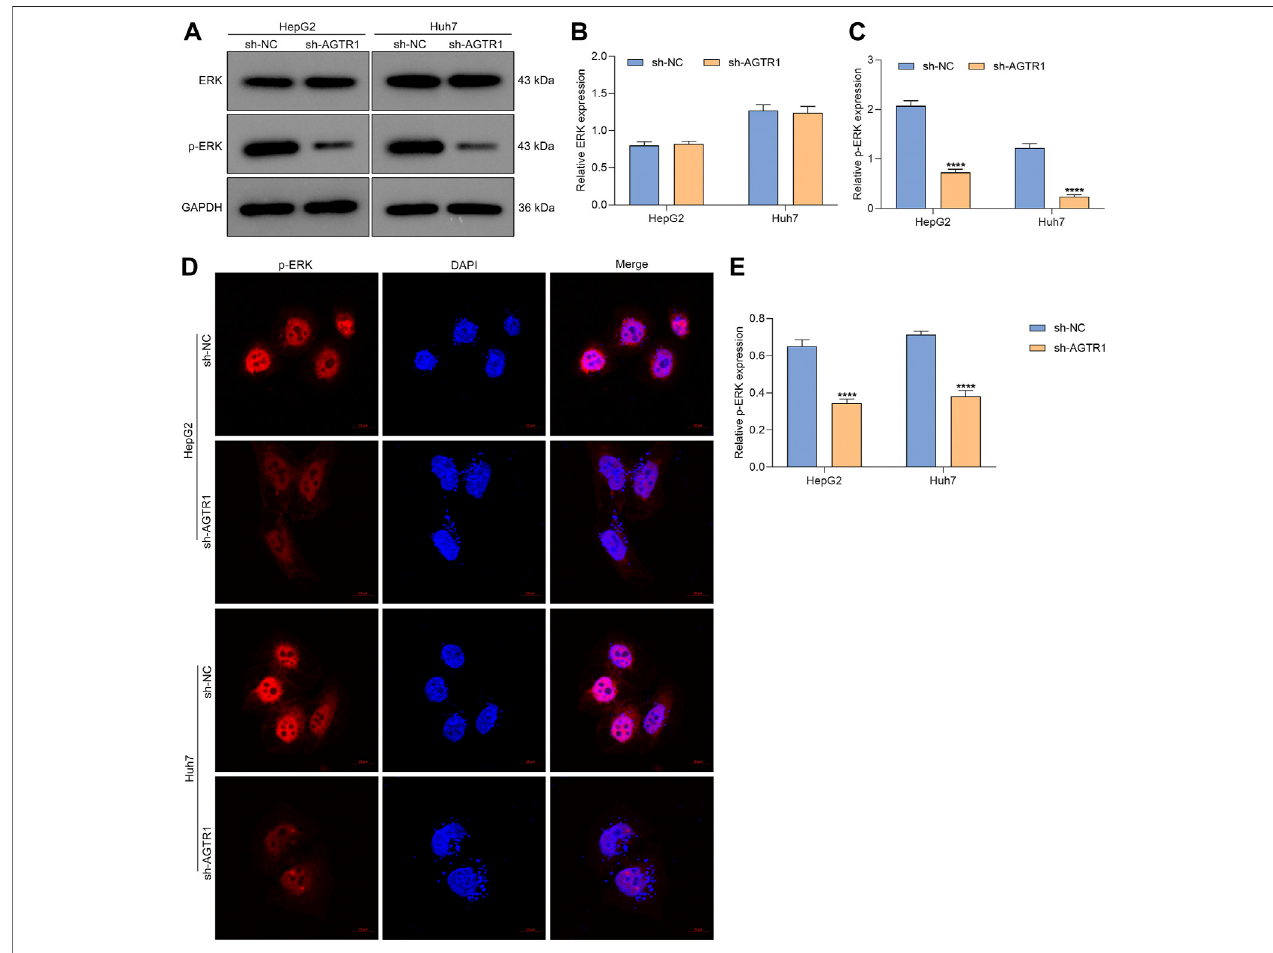
FIGURE 5 | Suppression of AGTR1 weakens ERK activity in HCC cells. (A – C) ERK and p-ERK levels in HepG2 and Huh7 cell lines with sh-AGTR1 lentivirus transduction. (D,E) Immuno fl uorescent staining of p-ERK in HCC cell lines with sh-AGTR1 lentivirus transduction. Scale bar, 10 μ m.